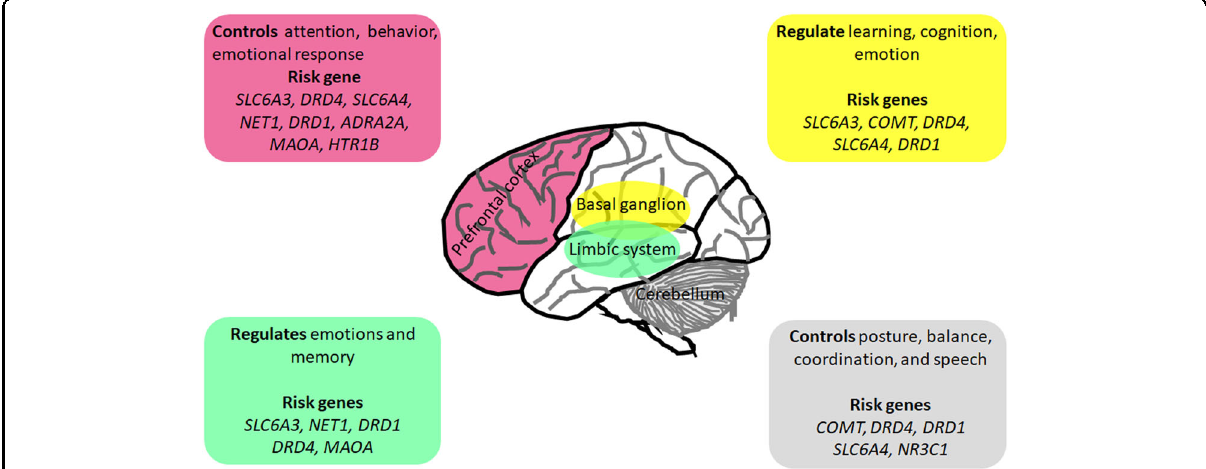
Fig. 2 Risk genes and associated altered brain regions in attention-de fi cit hyperactivity disorder. Multiples genes are associated with altered structural and functional brain changes, mainly in the frontal lobe, basal ganglion, limbic system, and